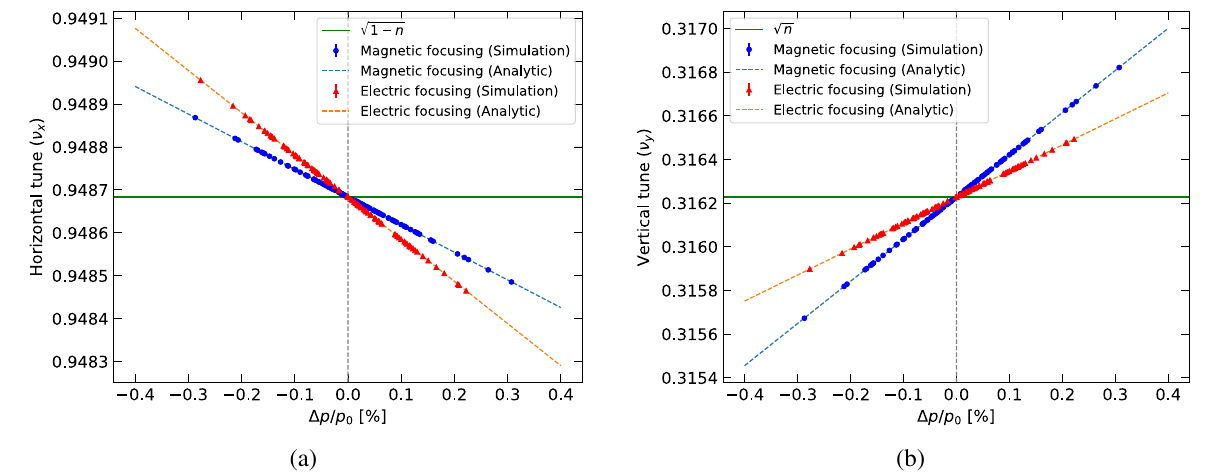
FIG. 2. The transverse betatron tunes from the high precision tracking simulation and the analytic estimation. Each point is a betatron tune obtained by fitting the betatron oscillations from simulation, which agree well with the analytical estimations, indicated as dashed ffiffiffiffiffiffiffiffiffiffiffi ffiffiffi p p 1 − n ; ν n lines. The reference tunes ð ν Þ are shown as green horizontal solid lines in each figure. Details of the simulation x 0 ¼ y 0 ¼ as a function of the fractional momentum offset. (b) Vertical tune setup and parameters are described in the text. (a) Horizontal tune ð v x Þ ð v y Þ as a function of the fractional momentum